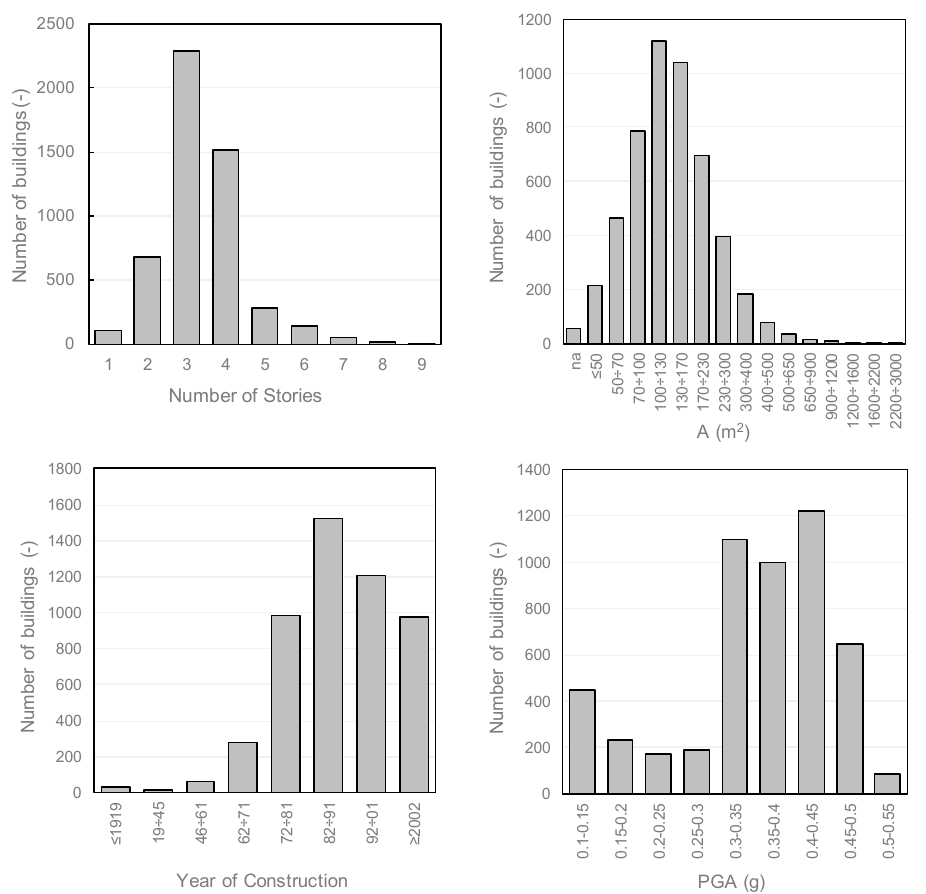
Figure 6. Frequency distributions of number of stories, plan area (A) (“na” = not available), year of construction, and PGA suffered during the L’Aquila 2009 earthquake for the analysed subset of buildings.